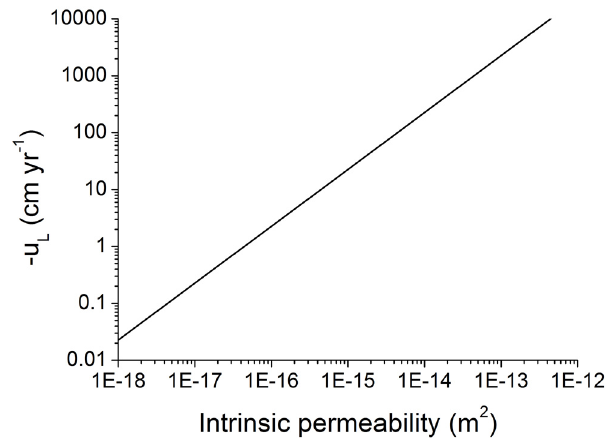
Figure 12. Velocity of Darcy fluid flow at lithostatic pressure ( u function of intrinsic permeability. Darcy flow is calculated applying density values